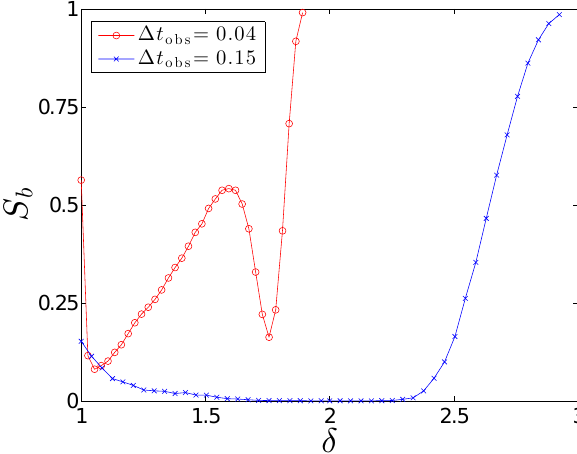
Fig. 7. Percentage S b of blow-ups as a function of the multiplicative inflation factor δ for fixed number of analyses cycles n a = 4000, integration time step d t = 0 . 0025 and observational noise variance R o = 0 . 01. We used k = 6 ensemble members.